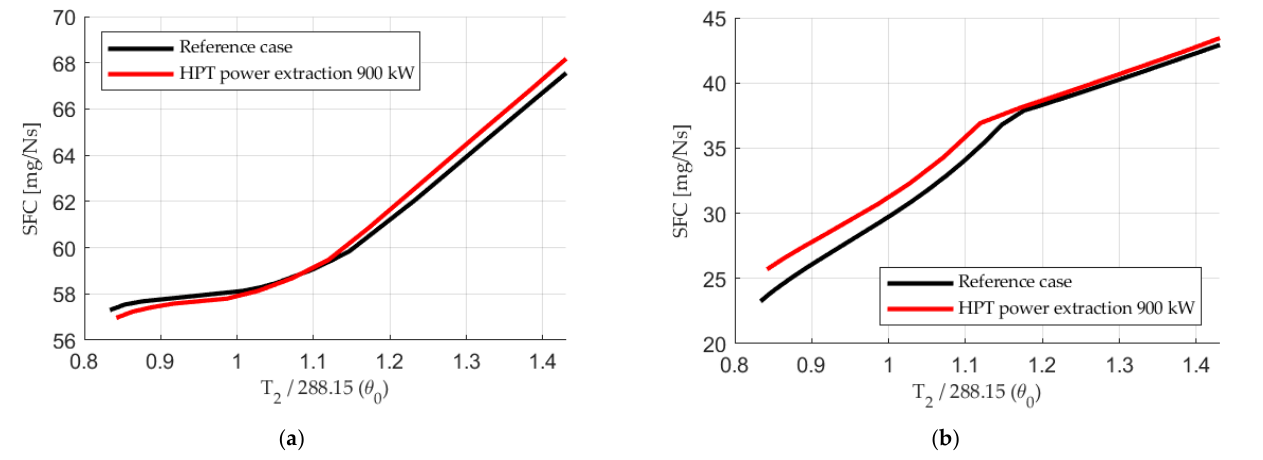
Figure 12. SFC plotted versus θ 0 (T t2 /288.15); ( a ) Maximum augmented power; ( b ) Maximum non-augmented power.